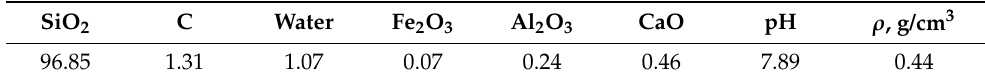
Table 7. Chemical composition of MCU-95, %